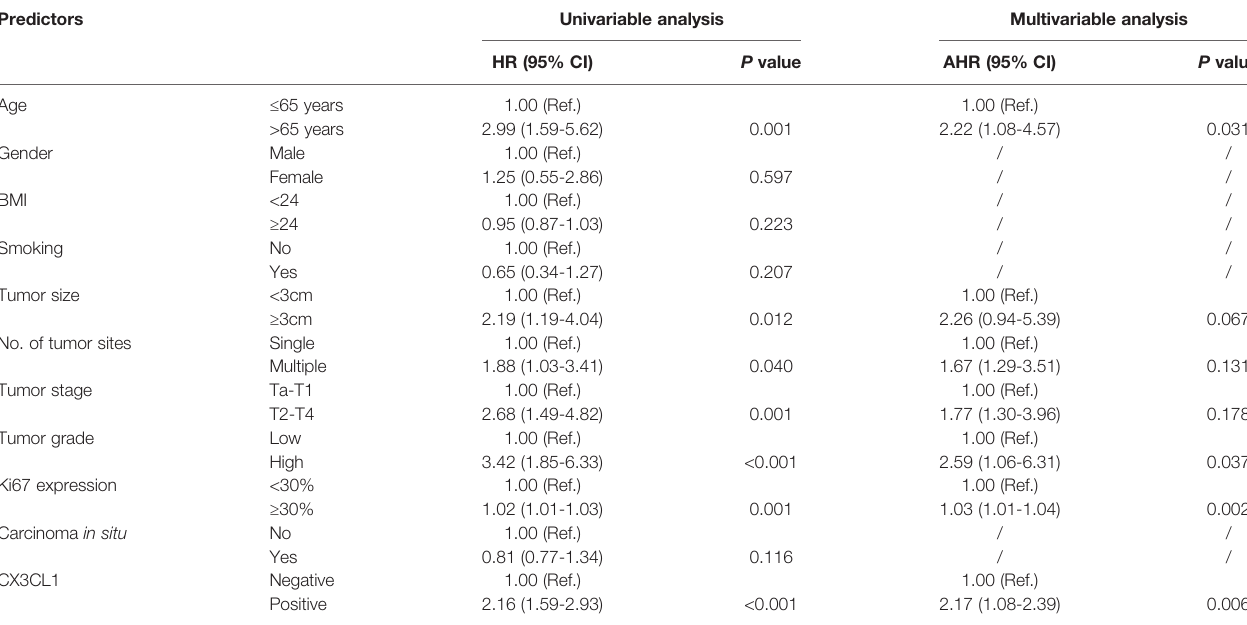
TABLE 3 | Univariable and multivariable-adjusted hazard ratios for cancer-speci fi c mortality in Cox proportional hazards models. Predictors Univariable